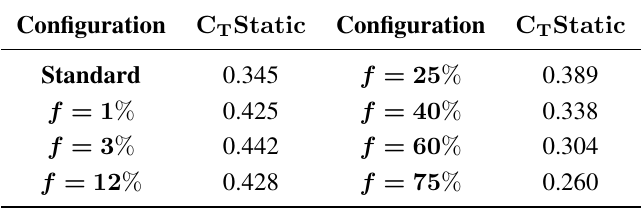
Static value over half a cycle of the Table 2. Average C T